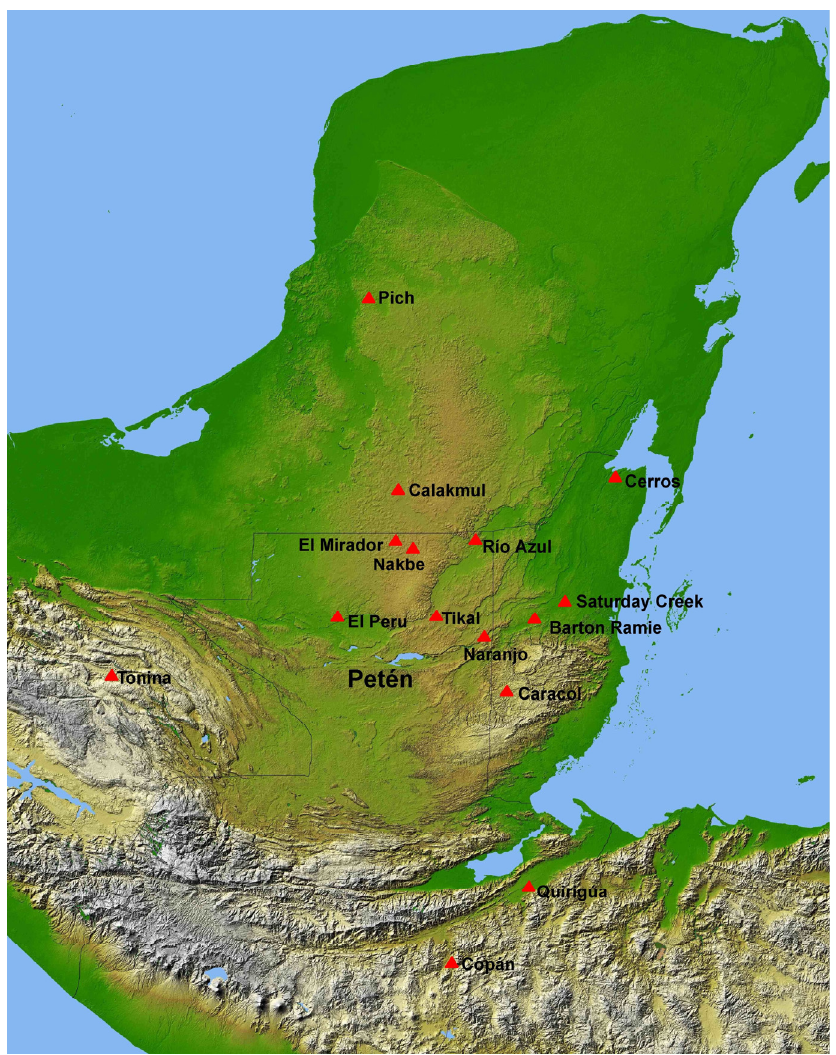
Figure 1. Map of the Maya area with sites and centers mentioned in text